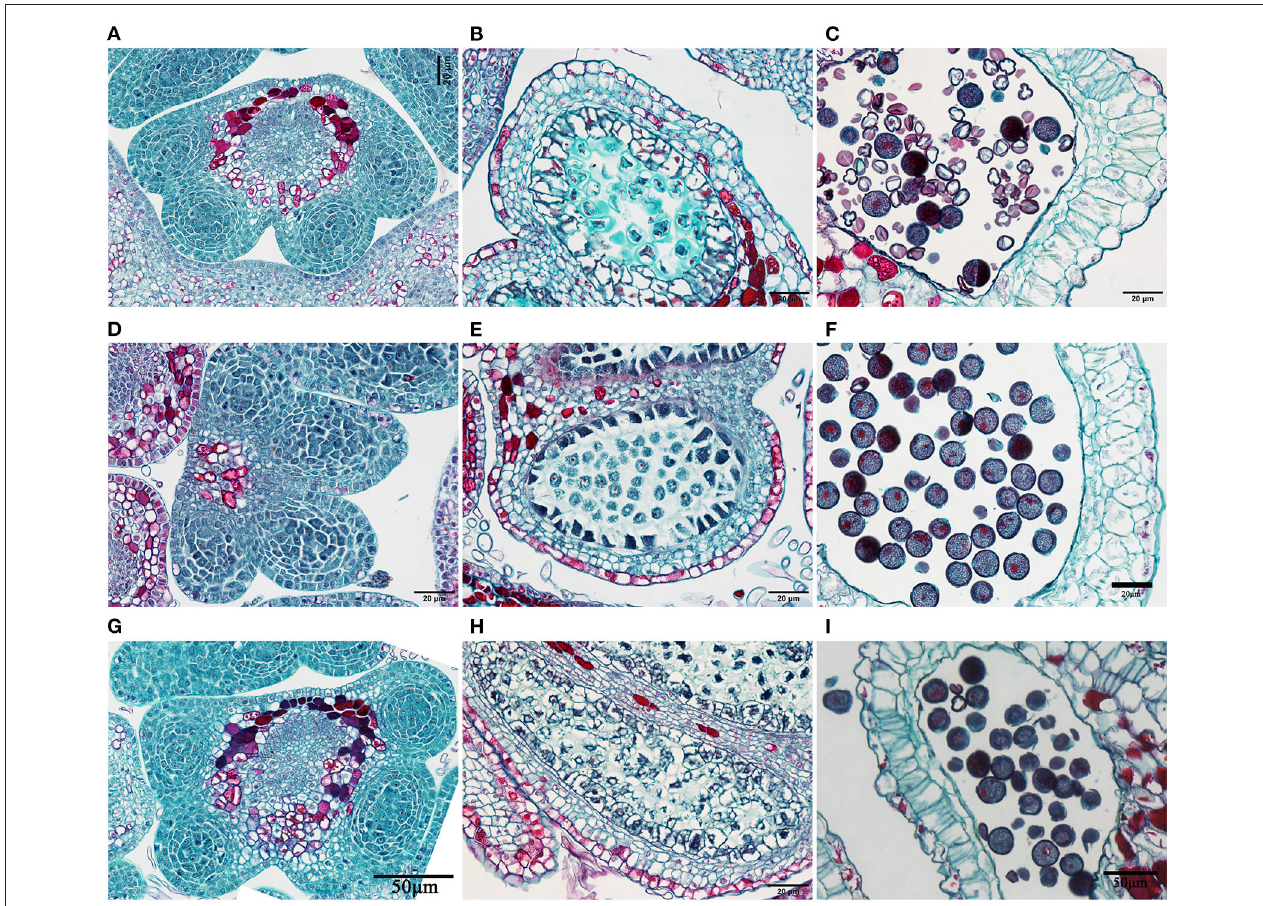
FIGURE 4 | Images of anther slices: (A–C) , Anther of H30-6 at the microspore mother cell stage (with microspore mother cells before meiosis), tetrad stage of meiosis stage, as well as the mature pollen stage; (D–F) anther of H411 at the microspore mother cell stage, meiosis stage, and mature pollen stage; (G–I) anther of B336 at the microspore mother cell stage, tetrad stage, and mature pollen